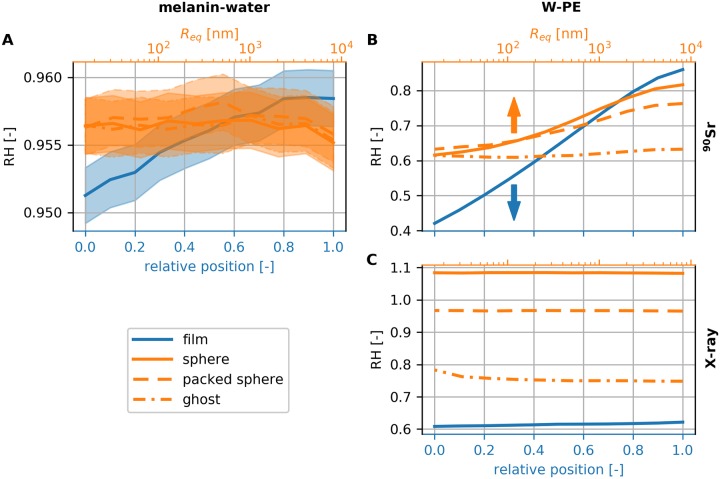
Comparison between different arrangements.(A) Relative radiant fluence for different spatial arrangements for the melanin-water composite and the 90Sr source. The relative film position is marked on the bottom x-axis and the equivalent radius for the lattice configurations at the top logarithmic x-axis. (B) Relative radiant fluence for the W-PE composite and the 90Sr source. The CI intervals are smaller than the line width. (C) Relative radiant fluence for the W-PE composite and the 40 kVp X-ray source. The CI intervals are smaller than the line width.